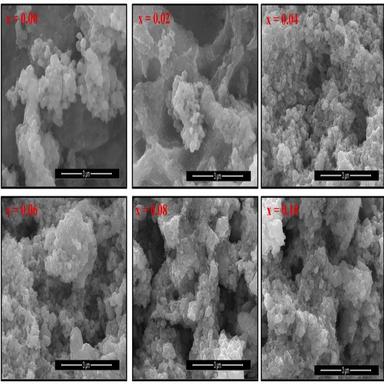
SEM images of NCZFe2-4xSn3xO4 NSFs.